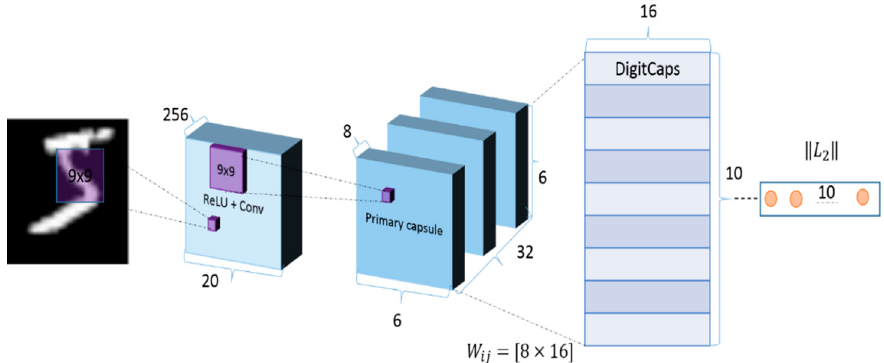
Figure 20. A CapsNet encoding unit with 3 layers. The instance of each class is represented with a vector of a capsule in DigitCaps layer that is used for calculating classification loss. The weights between the primary capsule layer and DigitCaps layer are represented with W ij .